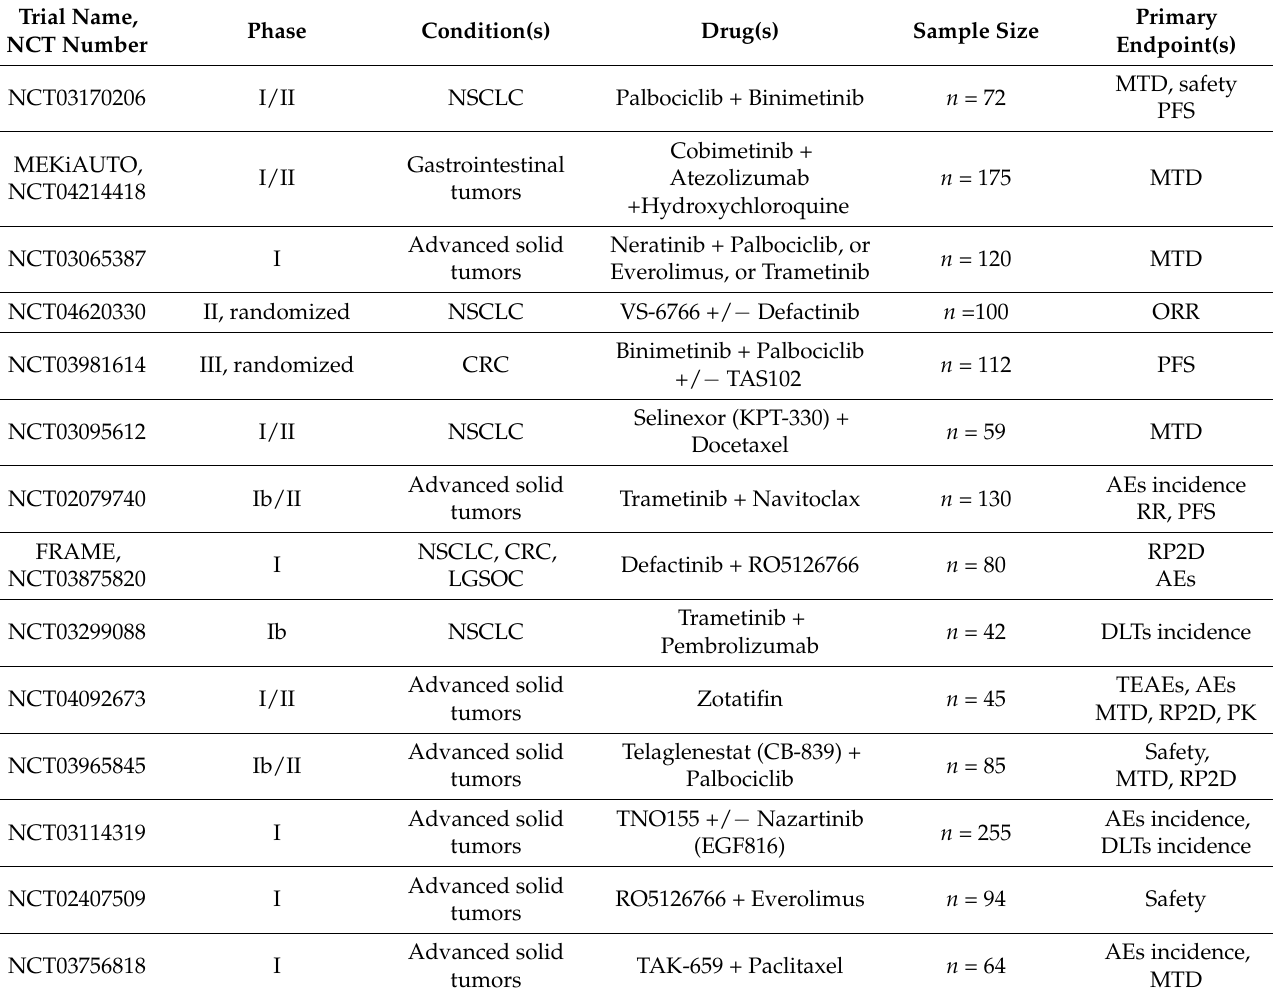
Table 2. Main characteristics of ongoing clinical trials of drugs targeting KRAS pathway in KRAS mutated tumors (source: https://clinicaltrials.gov, accessed on 11 March